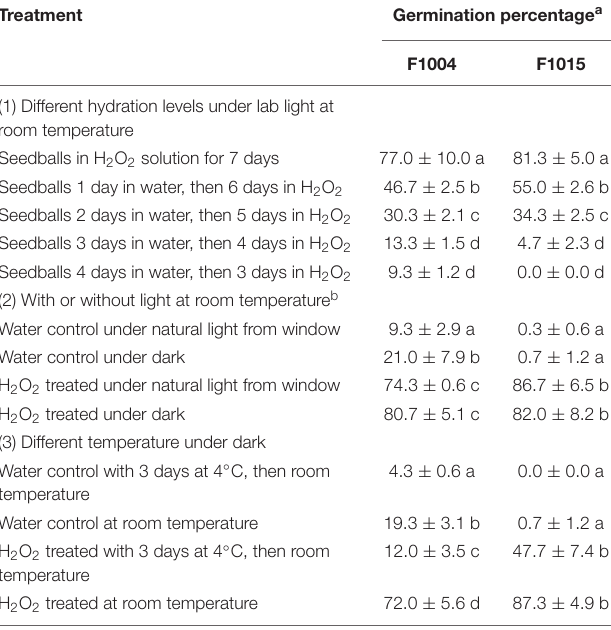
TABLE 1 | Germination induced by incubating seedballs of sugarbeet lines F1004 and F1015 in 1% H 2 O 2 solution for varying durations under fluorescent lights at room temperature.